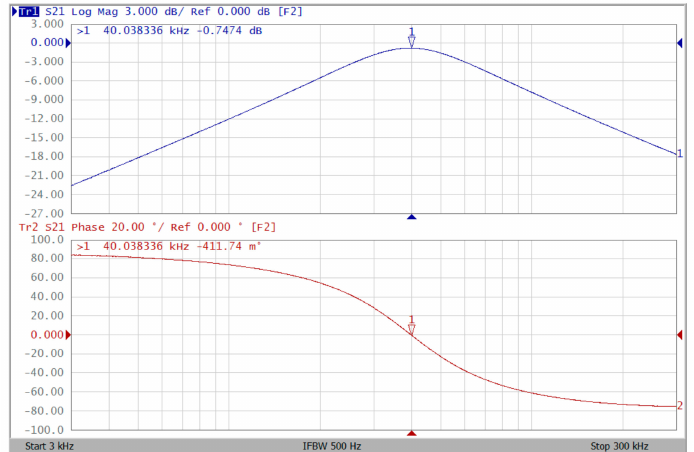
Figure 18. Measured gain and phase responses at V o1 when V i1 = V in and V i2 = 0.